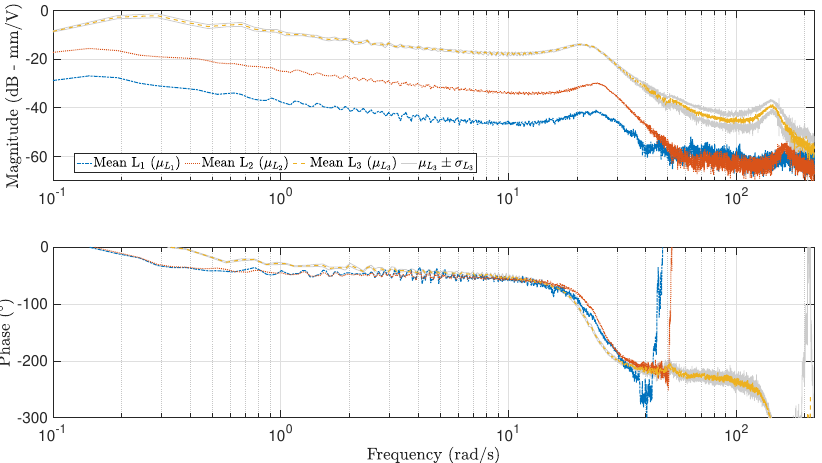
Figure 6. Frequency responses of the AEF swimimng robot for the excitation of first segment and the deflection in each IPMC